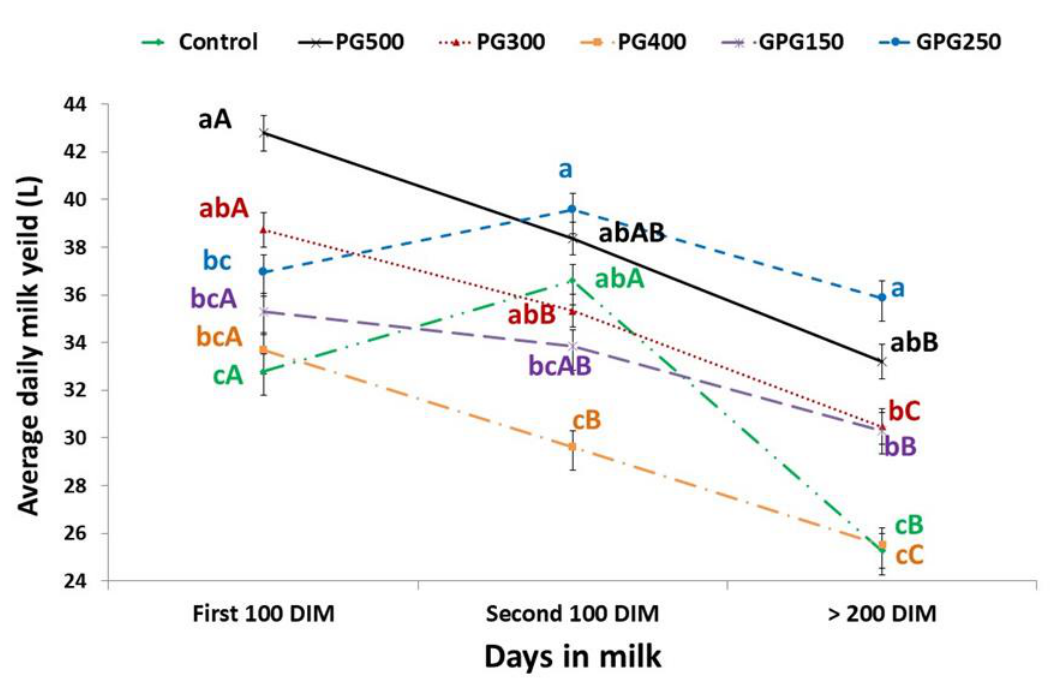
Figure 2. Effect of different drenching regimens by gluconeogenic precursors and time of assessment on average daily milk yield in first 100 DIM, in second 100 DIM and after 200 DIM. Means within duration with no common small superscript letters are significantly different ( p ≤ 0.05) (treatment effect). Means within treatment with no common capital superscript letters are significantly different ( p ≤ 0.05) ( time effect). The probability values of treatment effect, time effect and their interaction were <0.001, <0.001 and <0.001, respectively.